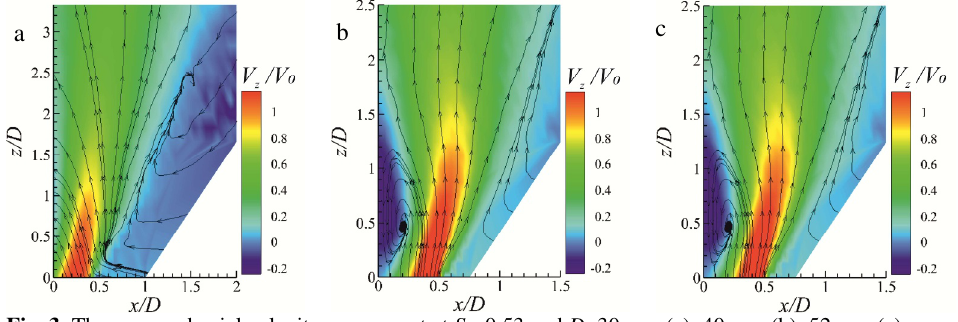
Fig. 3. The averaged axial velocity component at S g =0.53 and D =30 mm (a), 40 mm (b), 52 mm